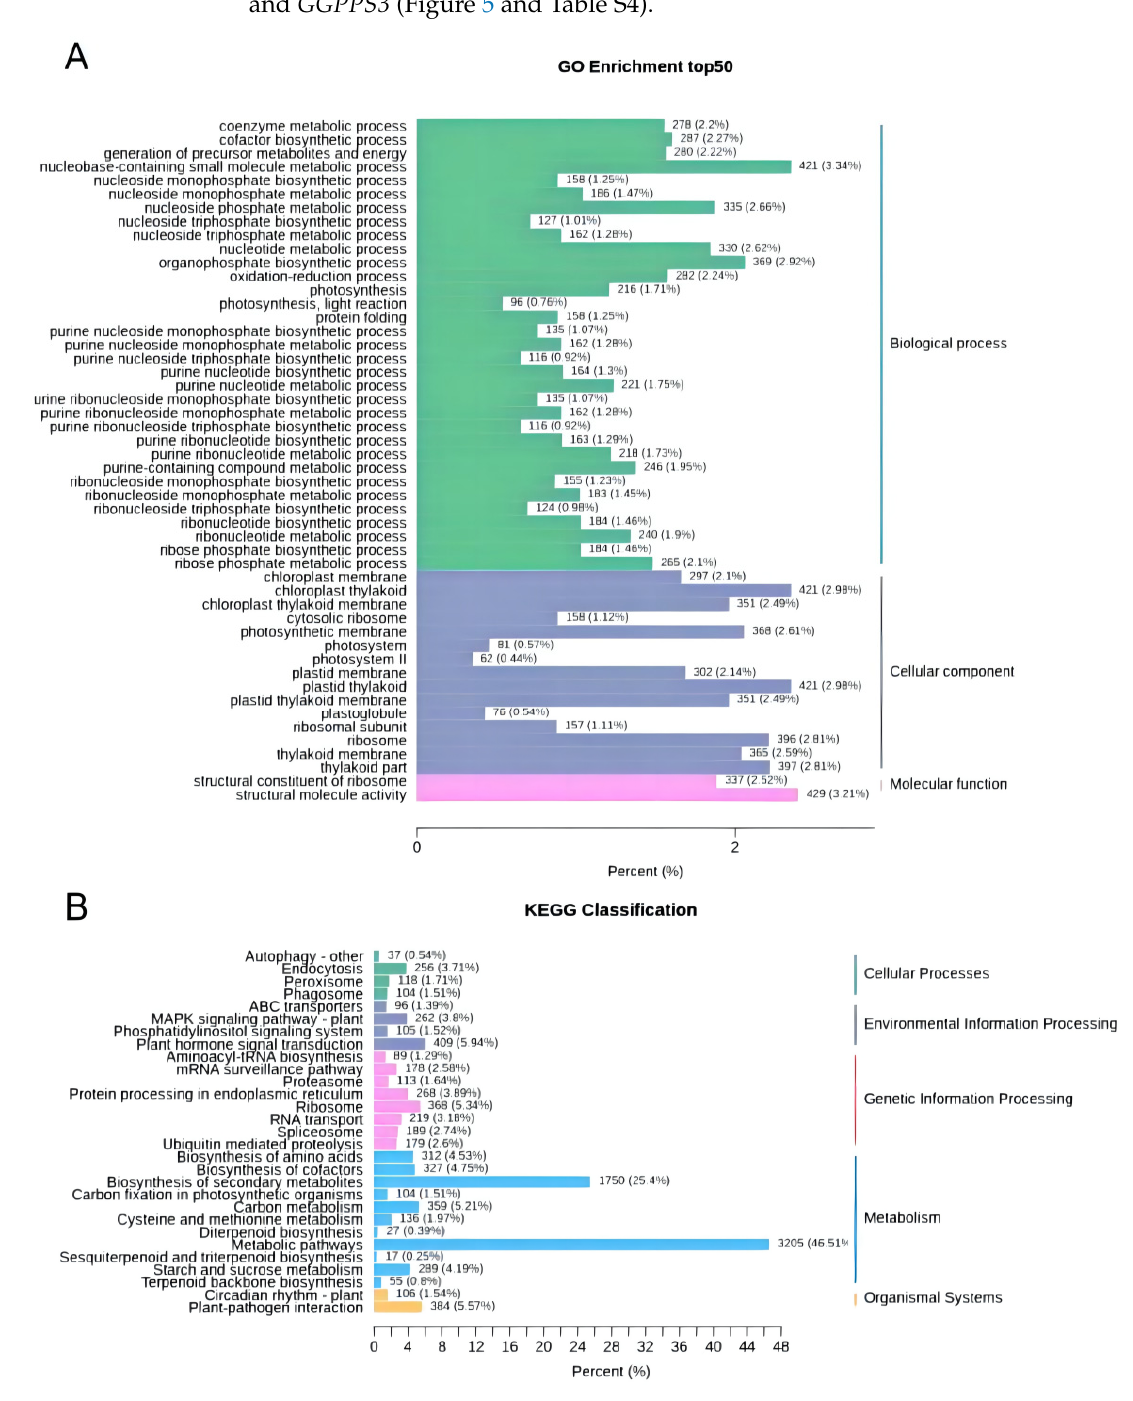
Figure 4. Annotation information of DEGs. ( A ) GO enrichment histogram of DEGs. The abscissa indicates the ratio of genes annotated to the entry to the total number of genes and the ordinate indicates the name of the GO entry. All DEGs were divided into three GO entries: biological process, cellular component, and molecular function. ( B ) KEGG classification column chart. DEGs were